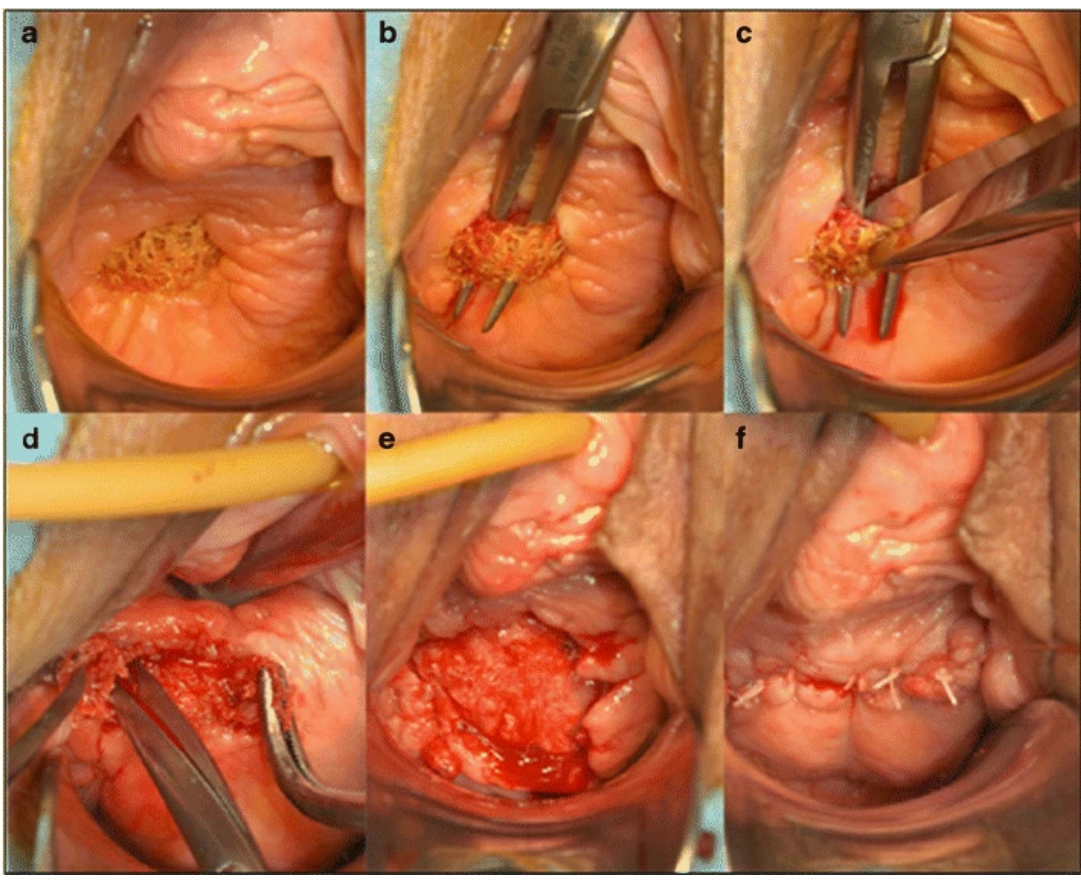
Figure 4. Photograph showing vaginal mesh exposure with steps taken for the partial removal of the mesh. ( a , b ) depict the exposure; ( c ) depicts sectioning and removal; ( d , e ) dissection of the surrounding tissue; ( f ) depicts wound closure following partial removal of mesh [30].